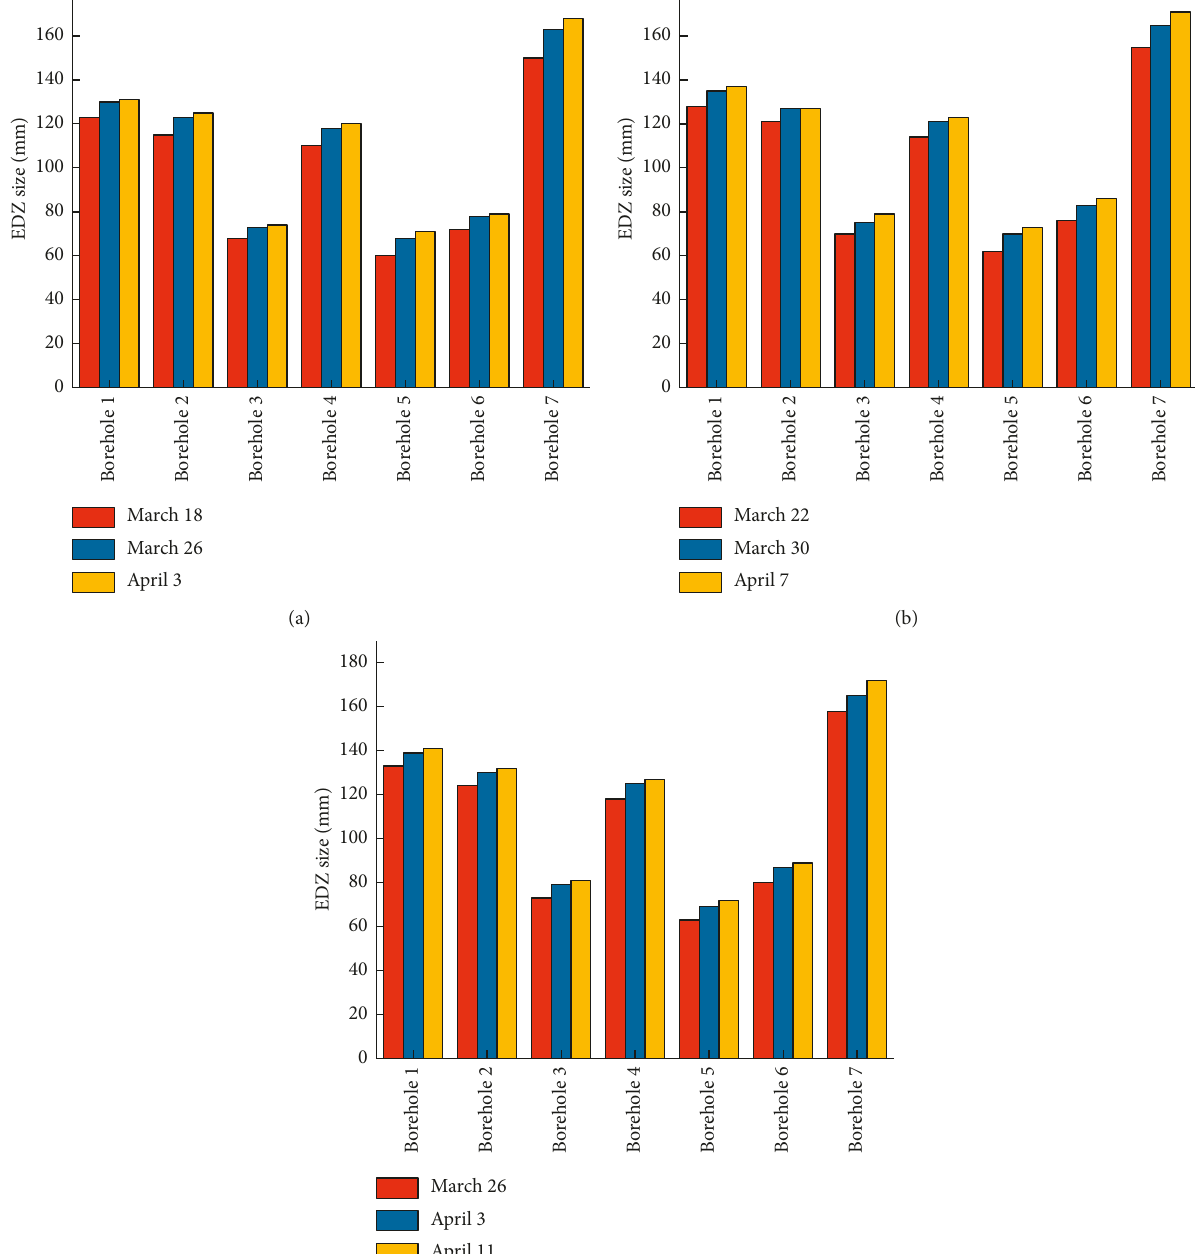
models based on the predicted and measured (real) values, 16 testing samples were validated by the optimized random forest model. The results are presented in Figure 13 and show actual vs. predicted EDZ by linear regression and random forest algorithm using the test data. Figure 13 suggests that all of the predicted values by random forest lie within ± 15% error off the line of perfect agreement. The RMSE and MAE between the observed and predicted values